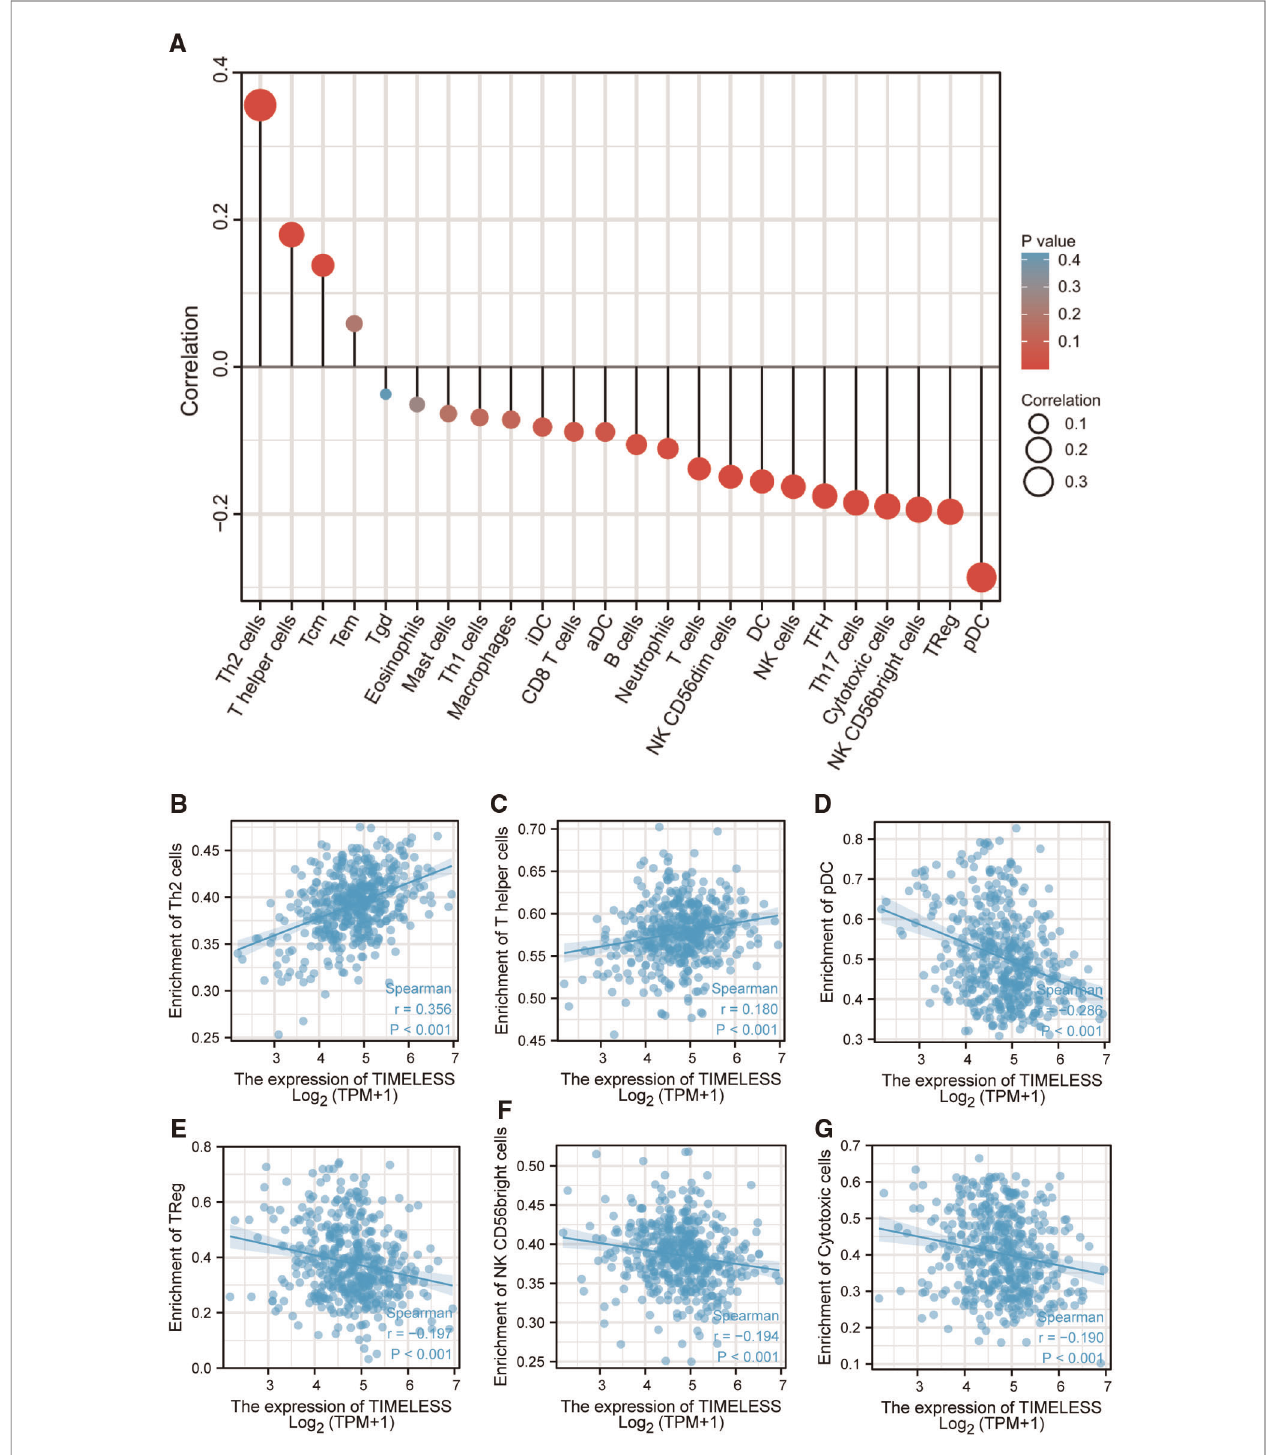
FIGURE 4 | The expression of TIM was associated with immune in fi ltration in the SKCM microenvironment. ( A ) Relationships among in fi ltration levels of 24 immune cell types and TIM expression pro fi les by Spearmans analysis. The comparison of in fi ltration levels of most correlated immune cells, including ( B ) Th2 cells, ( C ) T helper cells, ( D ) pDC, ( E ) TReg, ( F ) NK CD56bright cells, and ( G ) cytotoxic cells was